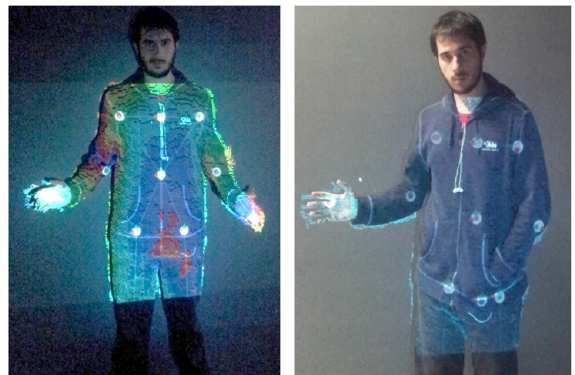
Figure 16 - Left: Depth Mapping with a Cyclic Scale. Right: Depth Mapping with a Two Color Scale. In both cases the skeleton mapping overlaps the corresponding mapping.